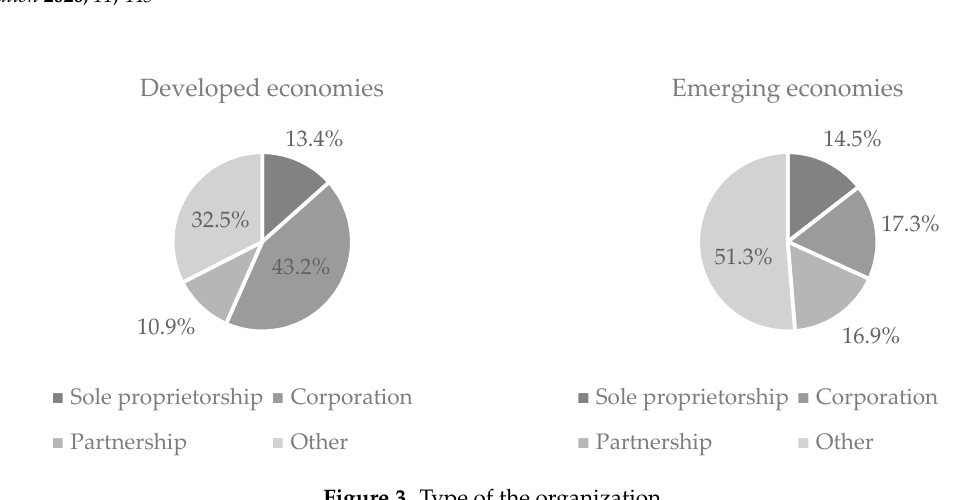
Figure 3. Type of the organization.